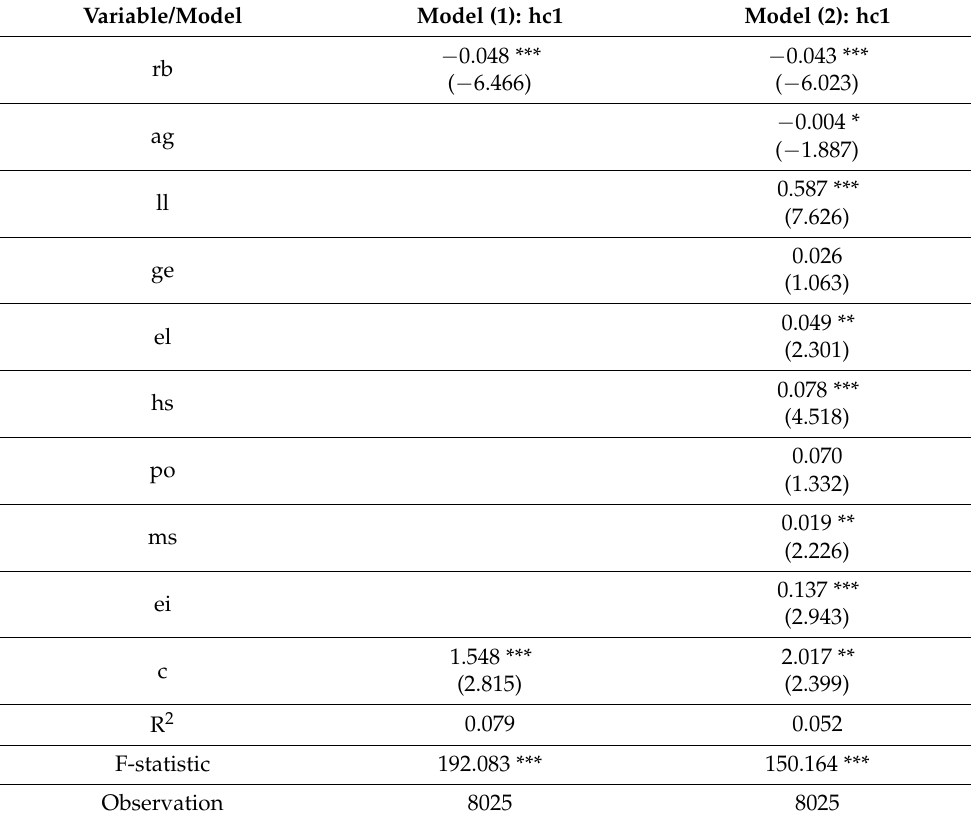
Table 3. Results of analysis of the effect of religious belief on human consumption (hc1).